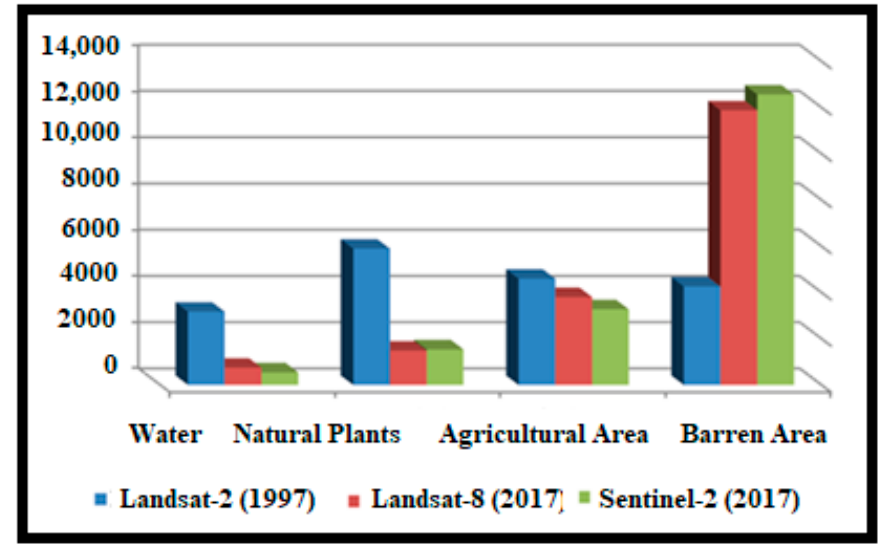
Figure 6. Comparison between areas of land covers classes in Iraqi southern marshes for three satellite images in 1977 and 2017.